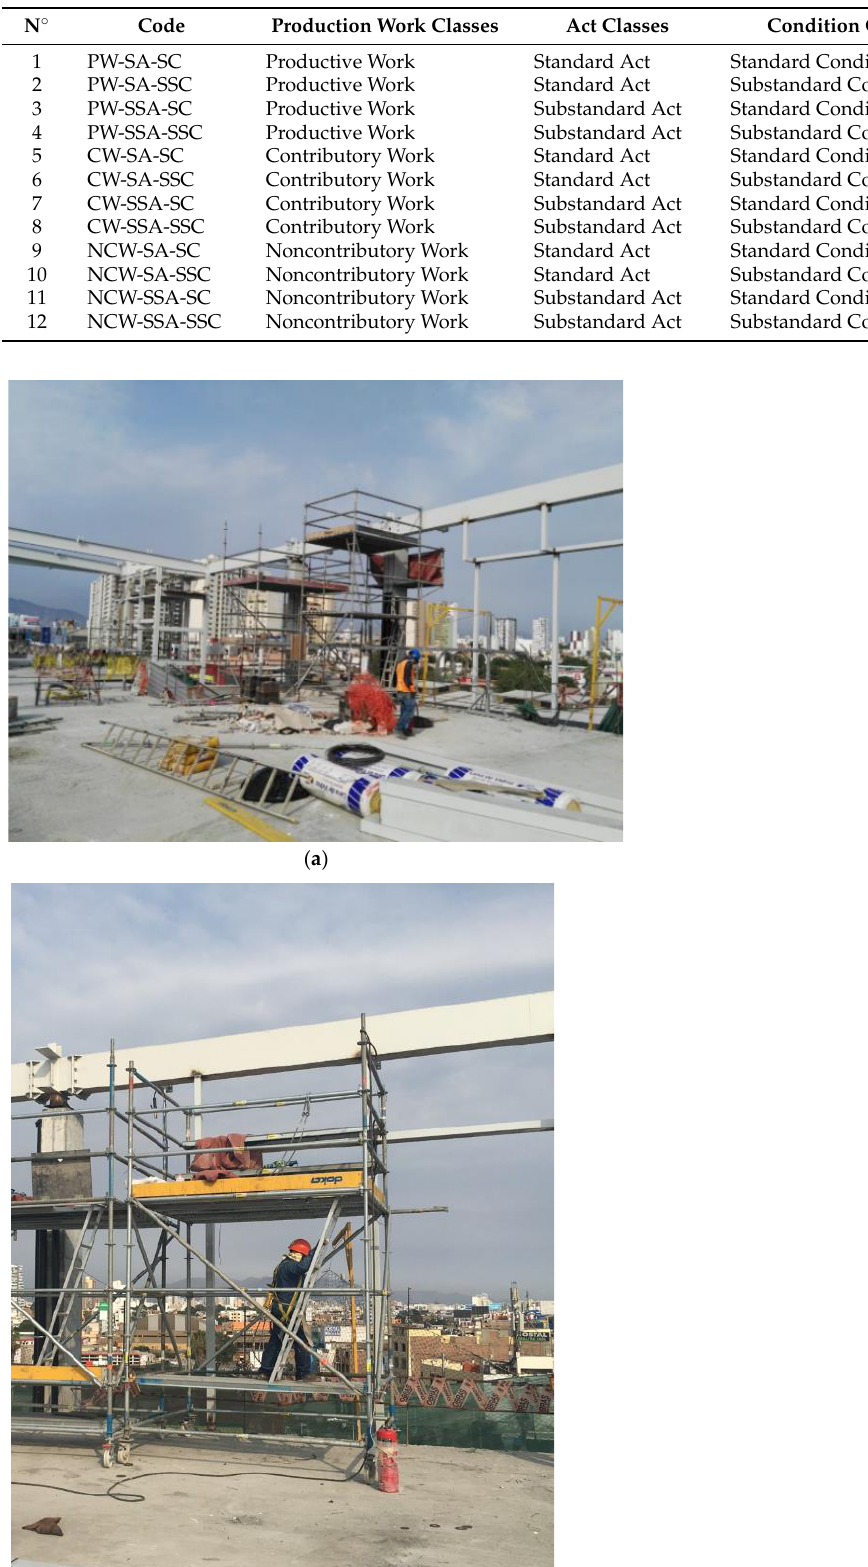
Table 1. Classification of production and safety work [11].